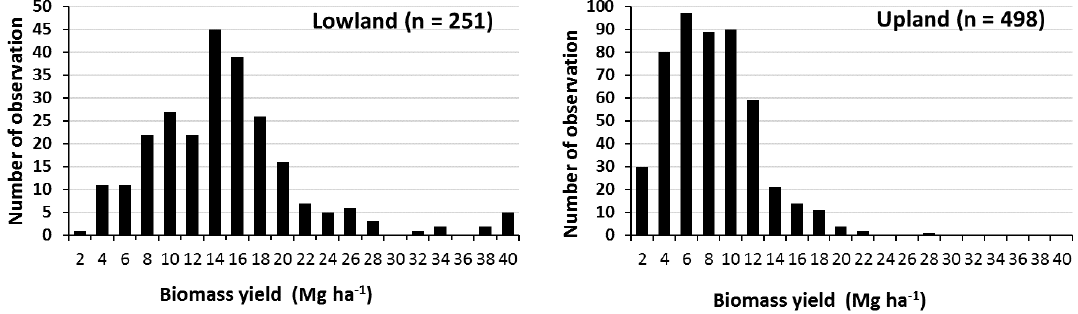
Figure 2. Frequency distribution showing biomass yields reported for upland and lowland cultivars. The number of observations analyzed for cultivars of each ecotype is shown in parentheses.